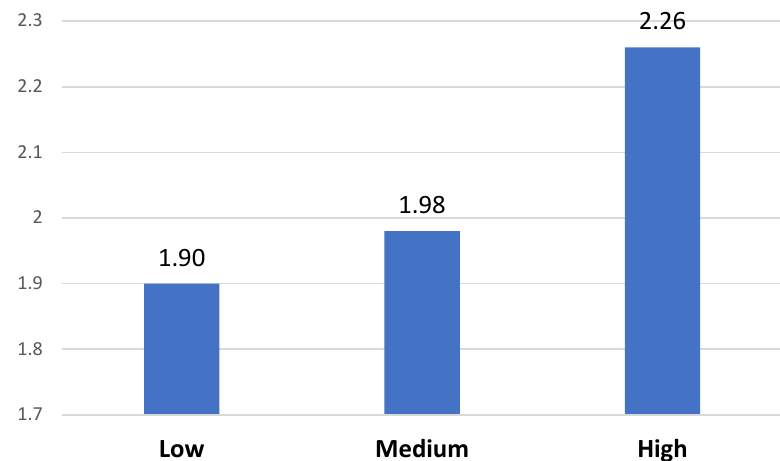
Figure 4. Social disconnection differences based on perceived phubbing levels.